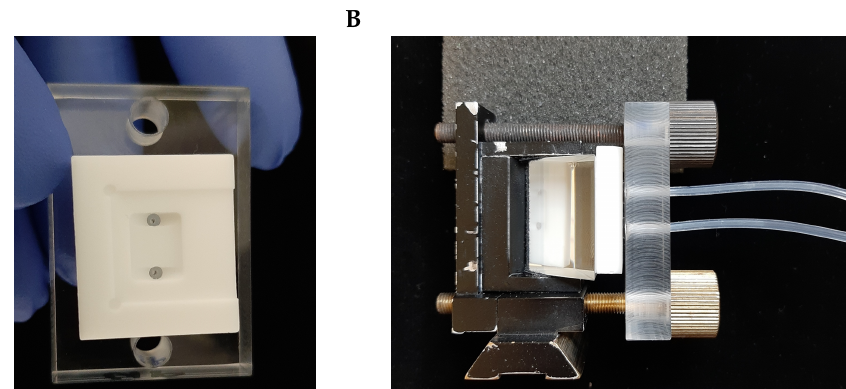
Figure 2. ( A ) a flow cell of the primary-version SPR microscopy sensor; ( B ) the assembly of a flow cell, a prism, and a prism holder ready to be placed at the rotation stage.